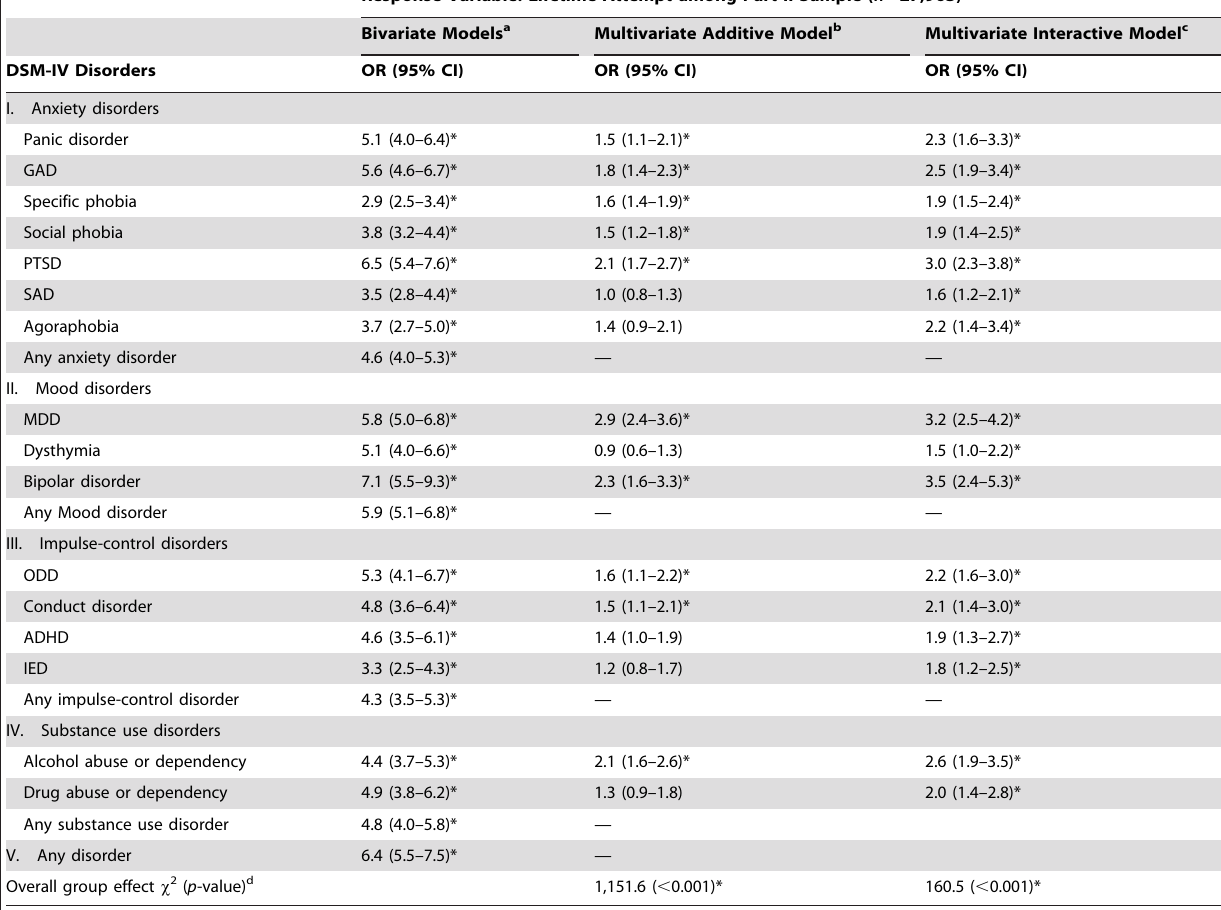
Table 2. Survival models of the associations between DSM-IV disorders and a subsequent suicide attempt—developed